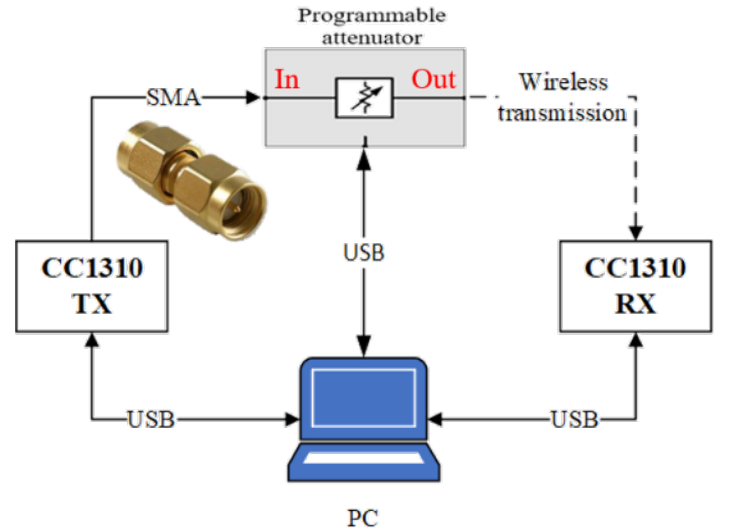
Figure 4. Experimental architecture for relation of PER and SNR.